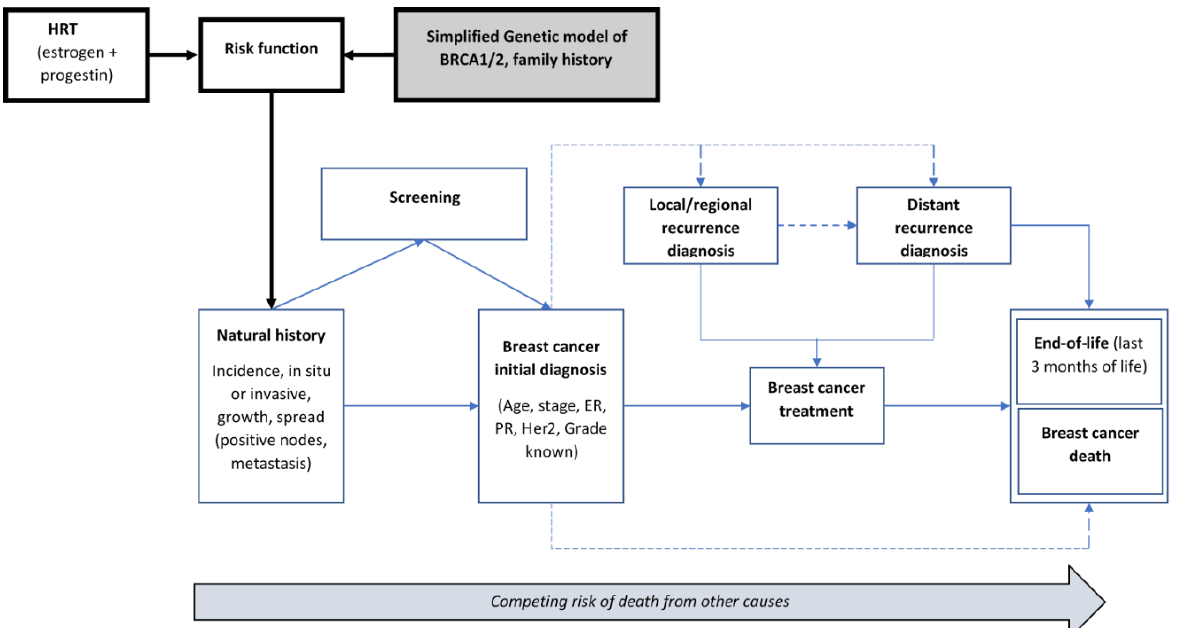
Figure 1. Schematic diagram of the OncoSim-Breast model.